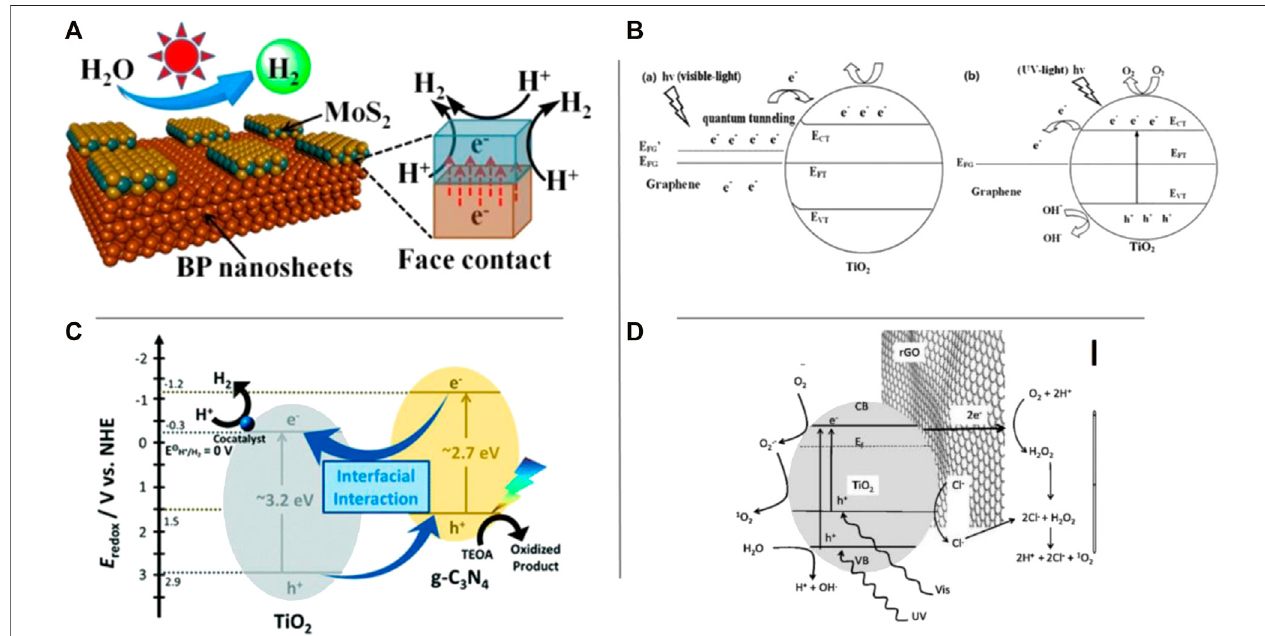
FIGURE 3 | (A) Schematic diagrams of 2D-2D BP-10000/MoS 2 photocatalysts. Reproduced with permission from Yuan et al. (2019), (B) Photocatalytic mechanismsofgraphene-TiO 2 compositeunder (a) visiblelight (b) UVlight,ReprintedwithpermissionfromG.Hu&Tang(2013), (C) TheenergydiagramoftheTiO 2 and g-C3N4 composites for photocatalytic H2 evolution under visible light irradiation. Reproduced from (Zhong et al., 2019), (D) Mechanism of photocatalytic generation of RSs on TiO 2 -rGO under UV and visible irradiation, and in the presence of chloride. Reproduced from Liu et al. (2019).